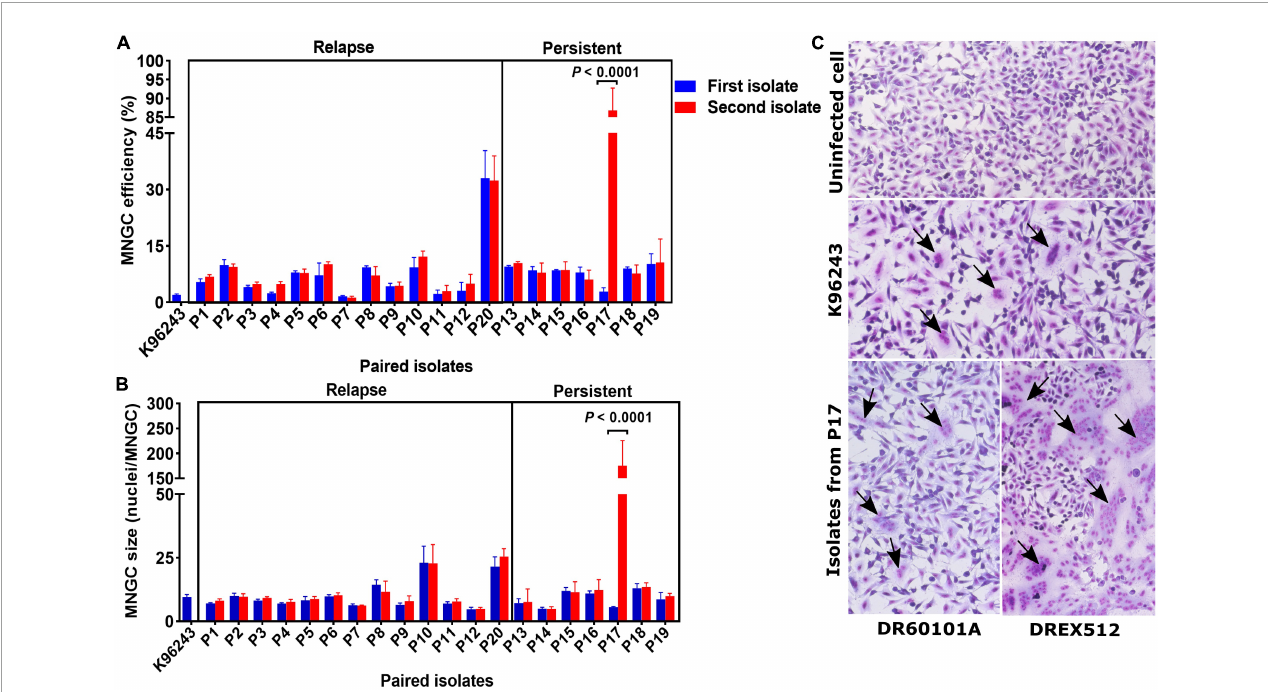
FIGURE2 Multinucleated giant cell formation (MNGC) formation in A549 cells infected with paired Burkholderia pseudomallei isolates from 13 relapse and seven persistent patients. (A) Comparison of MNGC efficiency between the first and second isolates. (B) Comparison of MNGC size between the first and second isolates. (C) Giemsa stain of uninfected A549 cells, A549 cells infected with reference B. pseudomallei K96243, and A549 cells infected with primary DR60101A and persistent DREX512 strains from P17. Black arrows point to the MNGC formation